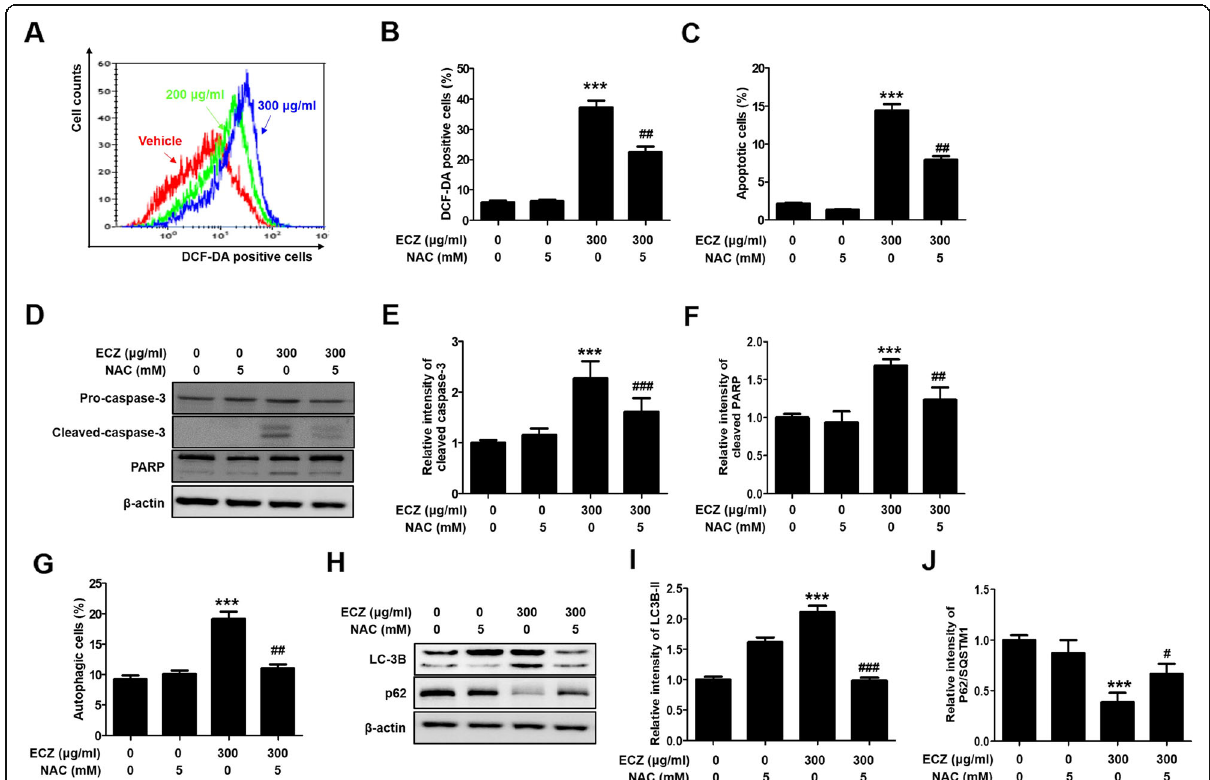
Fig. 4 Reactive oxygen species (ROS) regulated apoptosis and autophagy induced by ethanol extracts of Chrysanthemum zawadskii Herbich (ECZ) in mouse colon cancer CT-26 cells. a Representative histogram of intracellular ROS levels. Cells were treated with various concentrations (200 – 300 μ g/ml) of ECZ for 24 h, and dichlorodihydrofluorescein diacetate (DCF-DA) fluorescence intensity was detected by flow cytometry. b N- Acetyl-L-cysteine (NAC) attenuated the increased ROS production induced by ECZ. (C) NAC attenuated apoptosis induced by ECZ. d Effects of NAC on procaspase-3 and poly (ADP-ribose) polymerase (PARP) expression. e Relative fold change of cleaved caspase-3. f Relative fold change of cleaved PARP. g Effects of NAC on autophagy. h Effects of NAC on LC3B and p62/SQSTM1 expression. i Relative fold change of LC3B-II. j Relative fold change of p62/SQSTM1. Cells were treated with 300 μ g/ml of ECZ for 24 h prior to 1 h incubation with 1 mM NAC. ROS production, apoptotic cells, and autophagic cells were detected by flow cytometry. Total lysates were subjected to SDS-PAGE for Western blot analysis. Data are presented as the mean±standard deviation for at least three independent experiments. *** p <0.001 vs. the control group; # p <0.05, ## p <0.01, ### p <0.001 vs. the ECZ treated